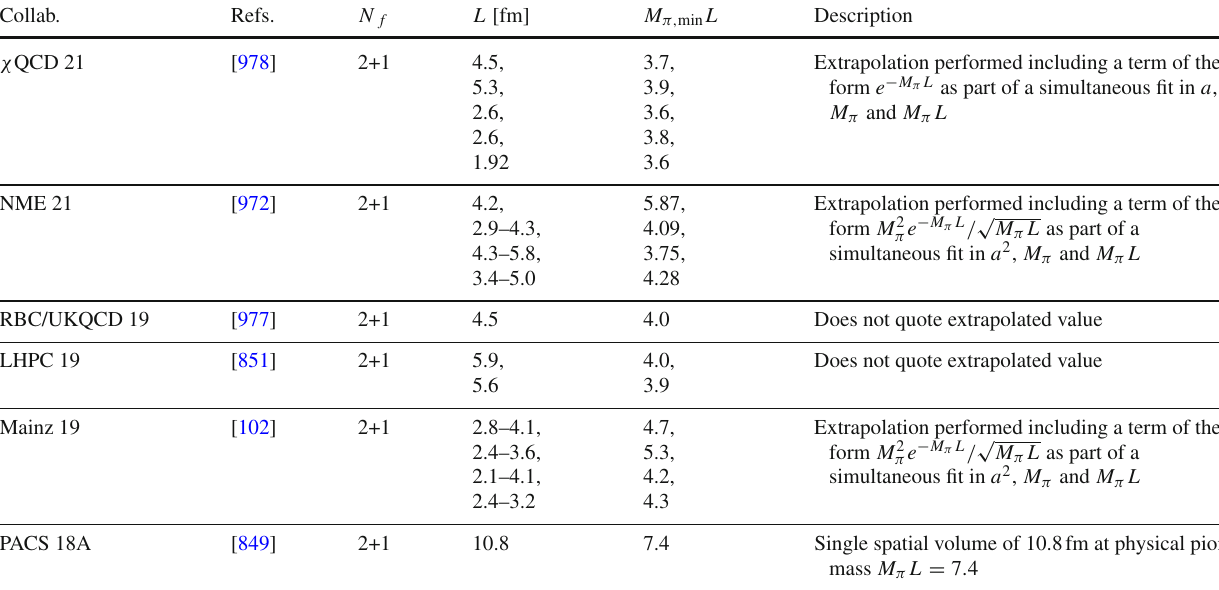
Table 179 Finite-volume effects in determinations of the isovector axial, scalar and tensor charges with N f = 2 + 1 quark flavours Collab.